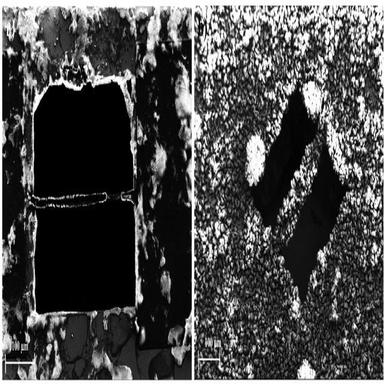
Fully suspended pyrolytic carbon string resonators after (a) 20 spray passes and (b) 200 spray passes.